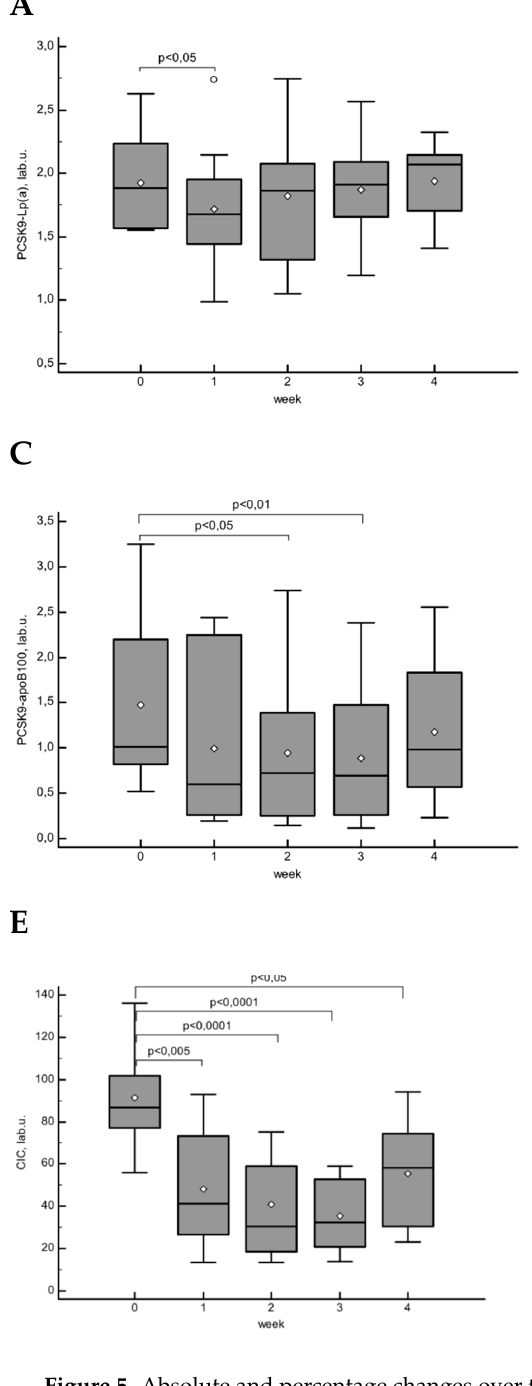
Figure 5. Absolute and percentage changes over time of circulating complexes of PCSK9–Lp(a) ( A , B ), PCSK9–apoB100 ( C , D ), and total pool of CIC ( E , F ).